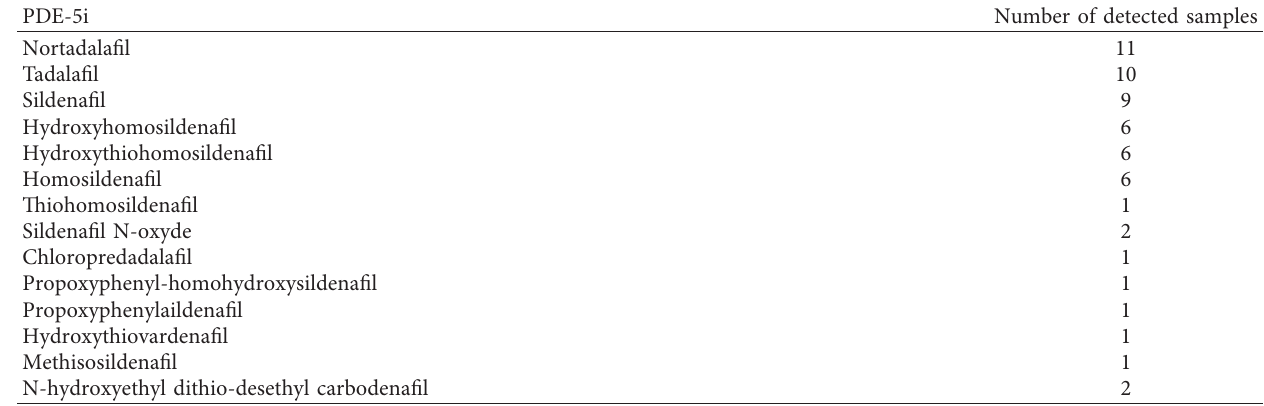
Table 2: Result of screening PDE-5i in 92 samples.